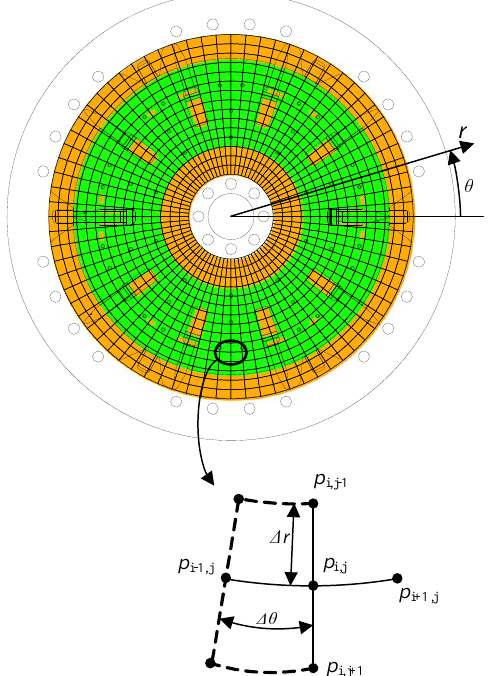
Figure 7: Finite difference mesh and boundary con- ditions. The color orange indicates that the pressure of the node is prescribed and green indicates that the pressure is to be determined. Figure 8: A section view of the FEM model with added